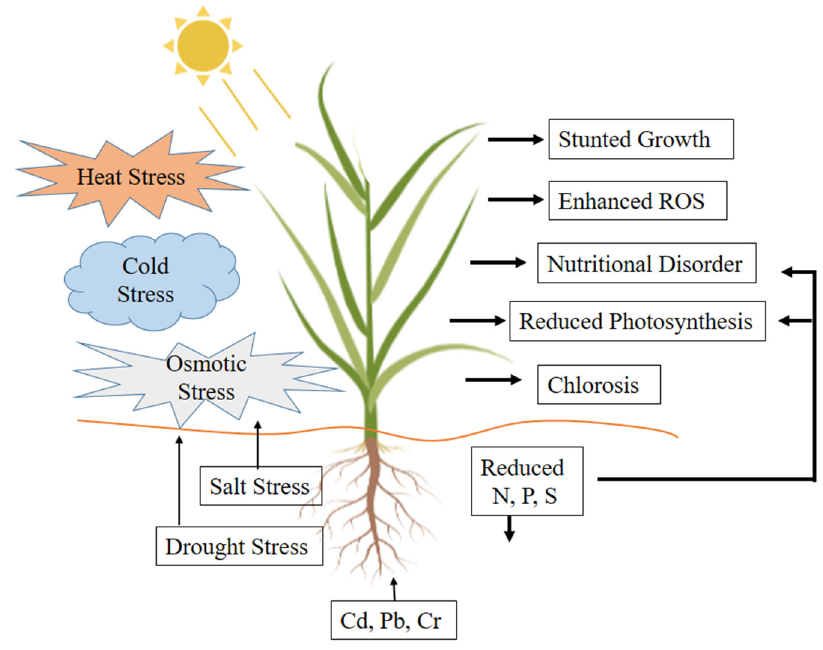
Figure 1. Adverse effects of abiotic stresses on root and shoot growth. Abiotic stresses adversely affect root growth, which results in an overall decrease in plant growth due to an extreme deficiency of water and nutrients in the aboveground parts of the plant.